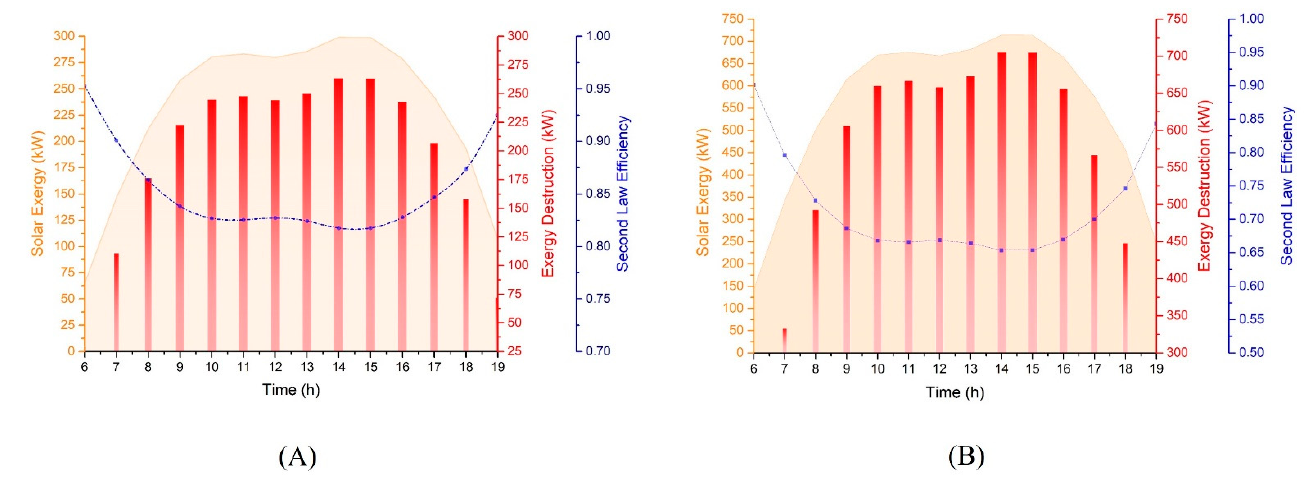
Figure 6. Variation in exergy destruction and exergetic efficiency with respect to solar exergy on a typical average summer day. ( A ) Alkaline process, ( B ) Supercritical process.